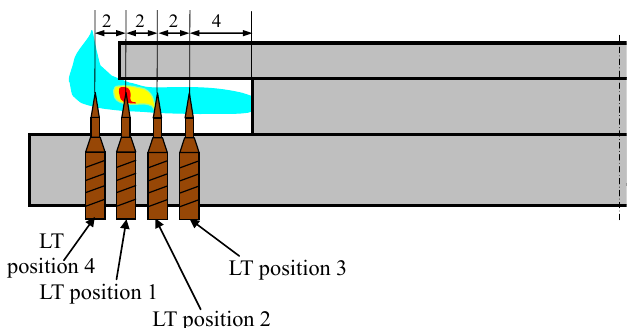
Figure 12. The positions of the linear thermocouple.